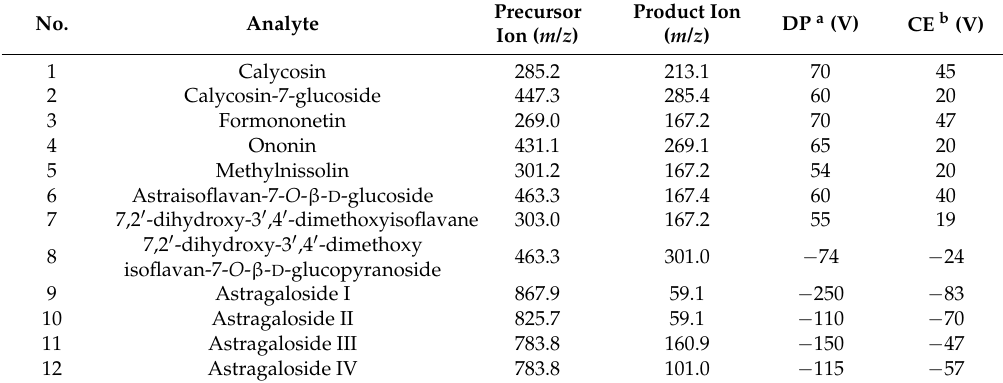
Table 1. Multiple reaction monitoring (MRM) transitions and parameters for the detection of the 12